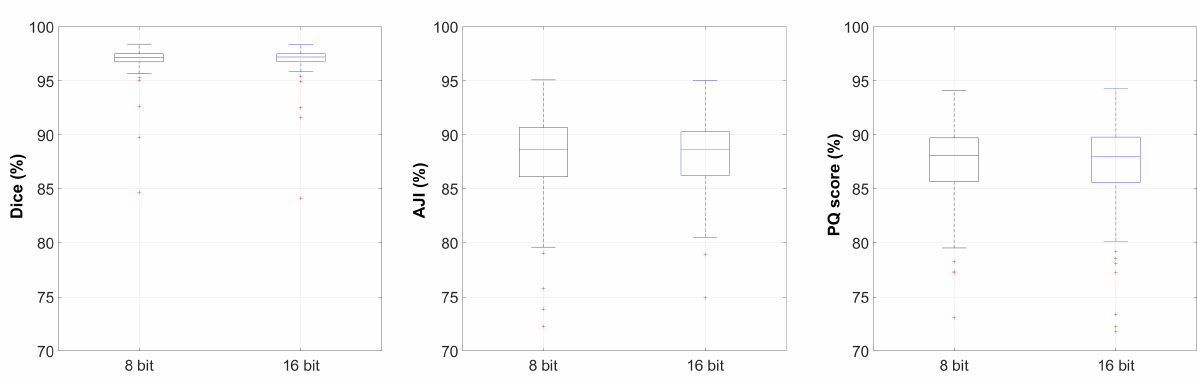
Figure 6. Nuclei instance segmentation performance boxplots for Dice, AJI and PQ scores derived from the Caicedo et al. dataset [10] (Y-axes are limited for better visualisation, and hence, some outliers are not